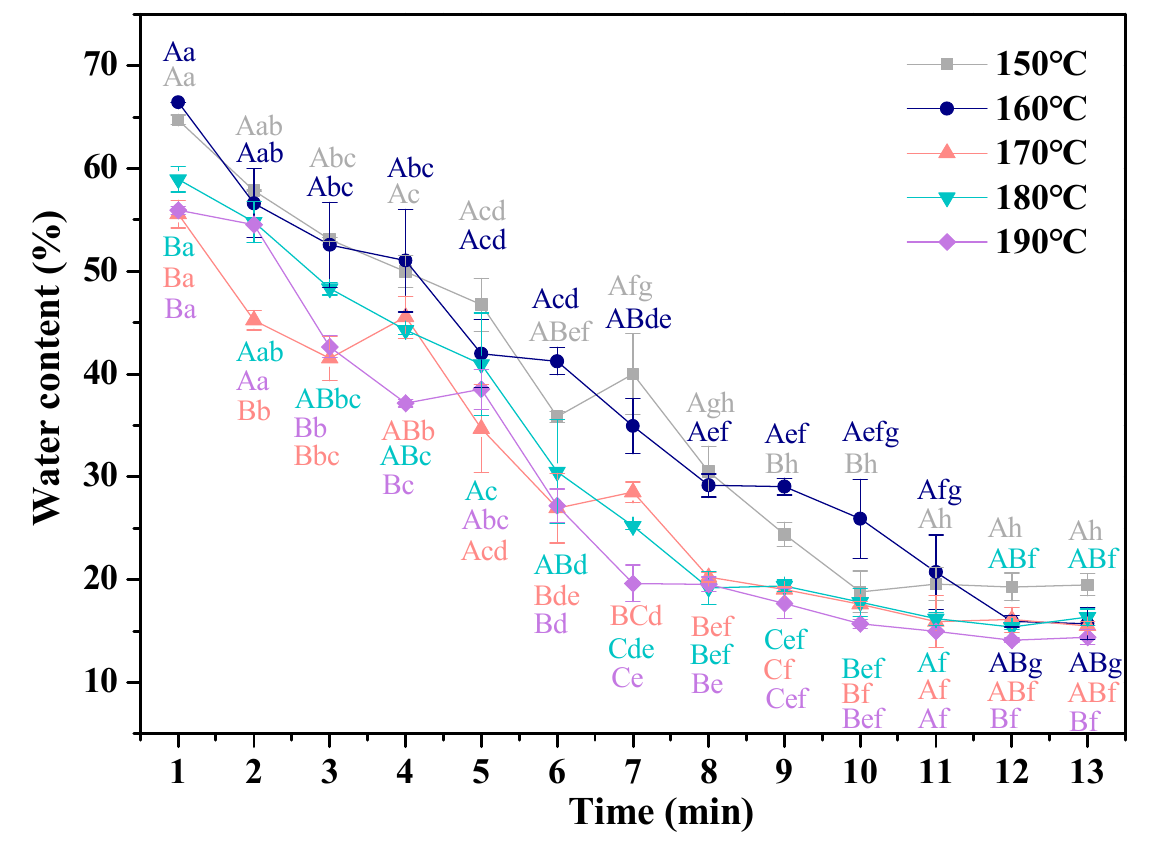
Figure 2. Effect of frying temperature and time on the water content of French fries. The results are the mean ± SE. Different capital letters (A–C) indicate significant differences within different temperature ( p ≤ 0.05), and different lower-case letters (a–f) indicate significant differences within different time ( p ≤ 0.05).